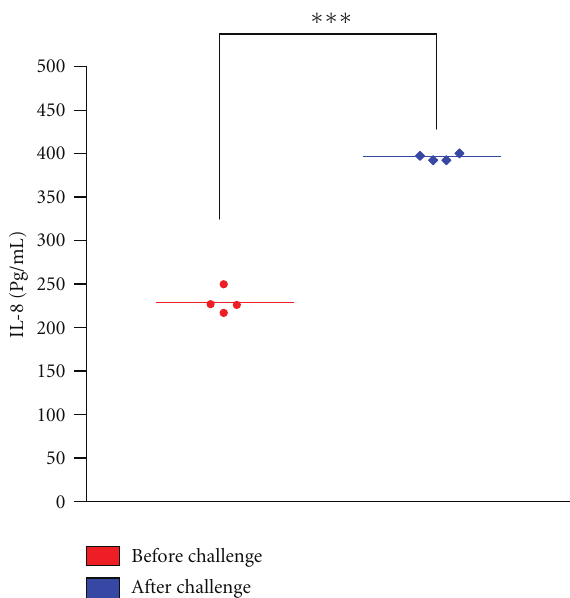
Figure 3: Amount of IL-8 secreted by NK cells of AR patients sensitized to HDM before and 6 h after nasal challenge with HDM allergen. Results are the mean ± SEM of 4 independent experiments. Asterisks indicate P < 0 . 05 by paired t